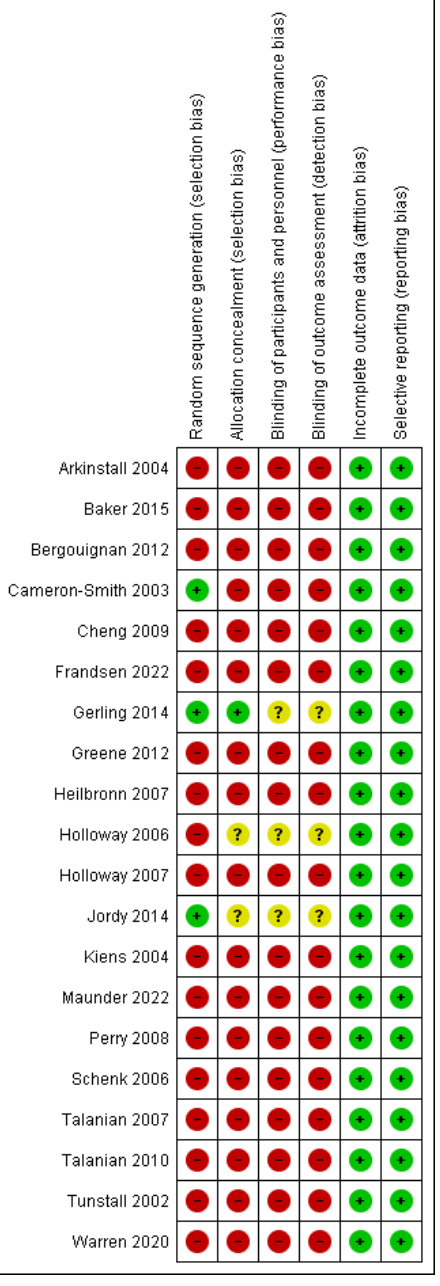
Figure 2. Risk of bias summary: review authors’ judgements about each risk of bias item for each included study [1,3,9,11,22–37].